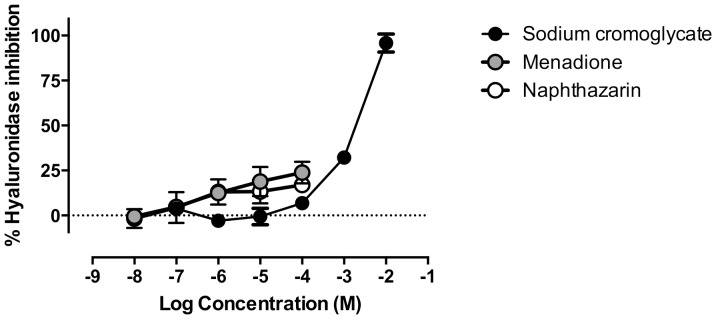
Concentration-dependent hyaluronidase inhibition by sodium cromoglycate (black circles) menadione (grey circles) and naphthazarin (white circles).
n = 3–4.